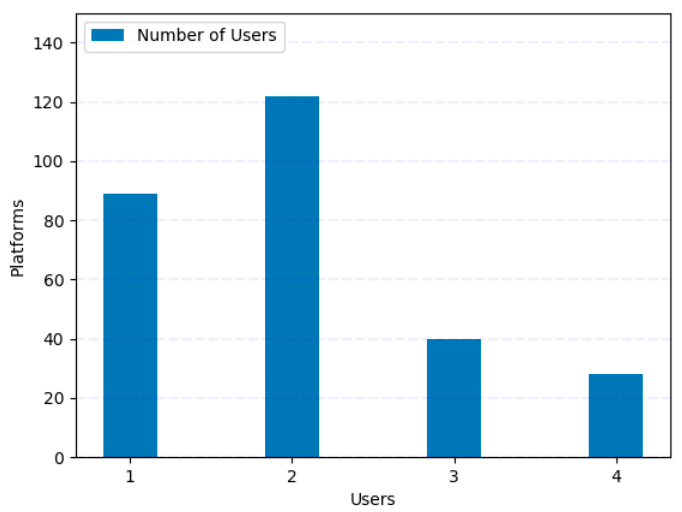
Figure 4. User data statistics.